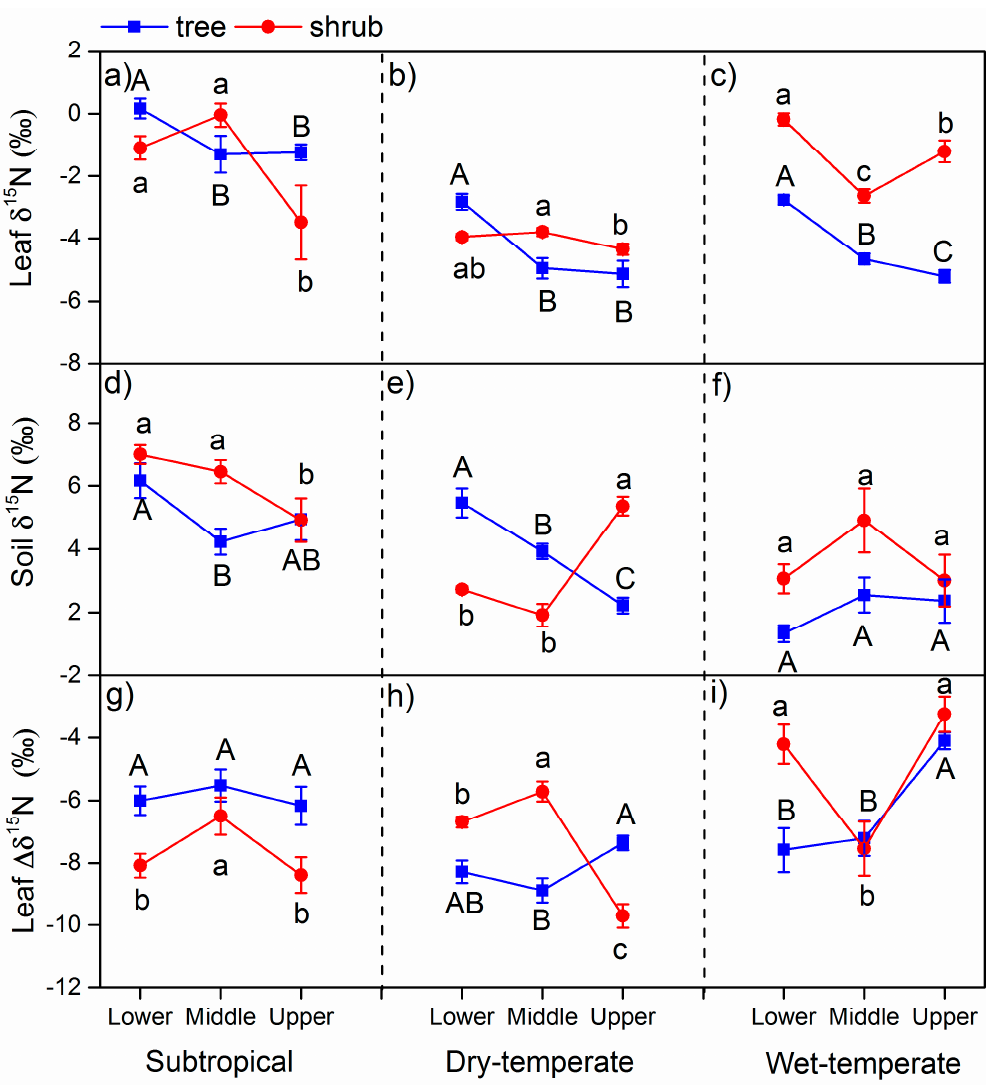
Figure 2. Leaf δ 15 N, soil δ 15 N and leaf ∆ δ 15 N (i.e., δ 15 N leaf − δ 15 N soil ) of trees and shrubs along the altitude in subtropical ( a , d , g ), dry-temperate ( b , e , h ) and wet-temperate mountain forest ( c , f , i ), di ff erent lower case letters indicate the difference for shrub δ 15 N between altitudes and upper case letters indicate the difference for tree δ 15 N between altitudes.